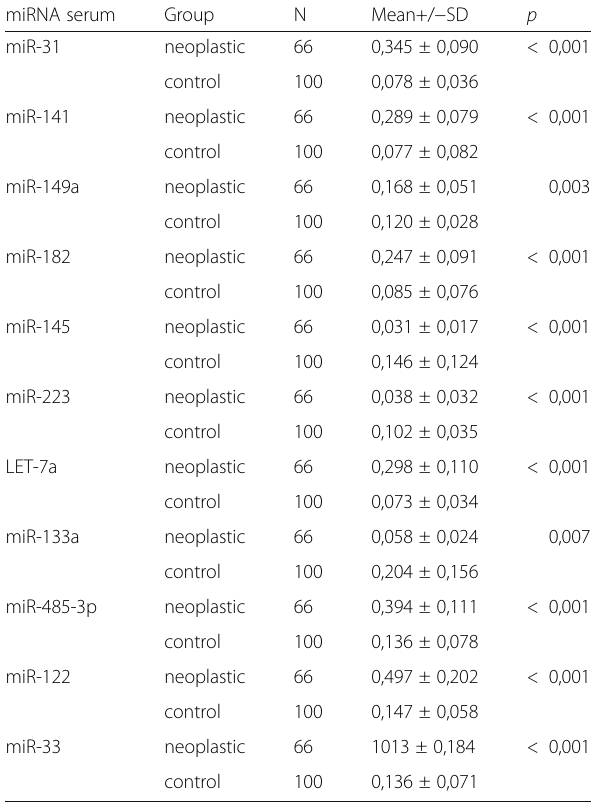
Table 2 The results of eleven selected miRNAs analyzed by RT-qPCR miRNA serum